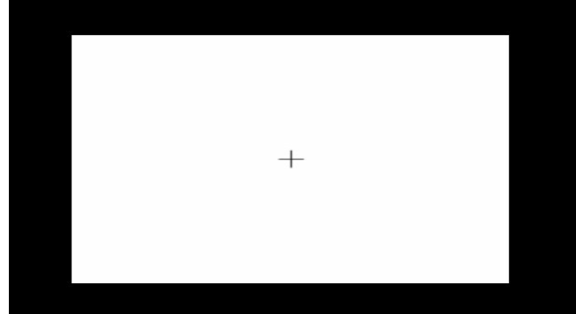
Figure 3. Control environment.